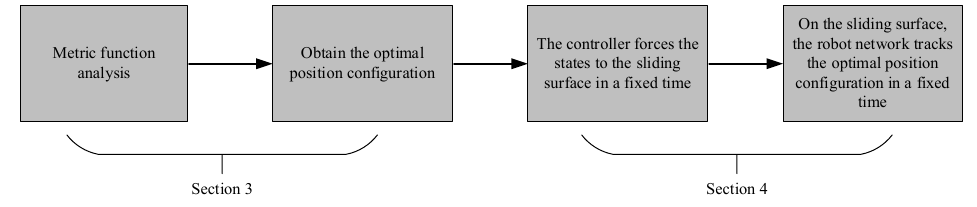
Figure 2. Fixed-time coverage control process of a mobile robot network with respect to the time cost